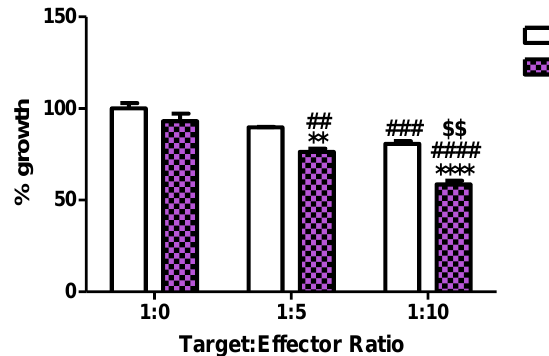
Figure 10. NK-92 cytotoxicity in a co-culture model with HCT 116. NK-92 and HCT 116 were co-cultured at various target:effector cell ratios alone or in the presence of Ara-C/DS (10 nM Ara-C, 0.2 µg/mL DS). After 48 h, NK-92 cells were removed and the growth of HCT 116 was measured using the SRB assay (data represented as a triplicate ± SEM). Statistical analysis was performed using a 2-way ANOVA with Bonferroni post hoc test where **** p < 0.0001 and ** p < 0.01 compares Ara-C/DS treated cells to non-treated cells for the respective target:effector ratios; #### p < 0.0001, ### p < 0.001 and ## p < 0.01 compares the 1:5 and 1:10 target: effector ratios to the cultures devoid of NK-92 (1:0 ratio) for each respective treatment; and $$ p < 0.01 compares the 1:10 target: effector ratios to the 1:5 target: effector ratios for each respective treatment.